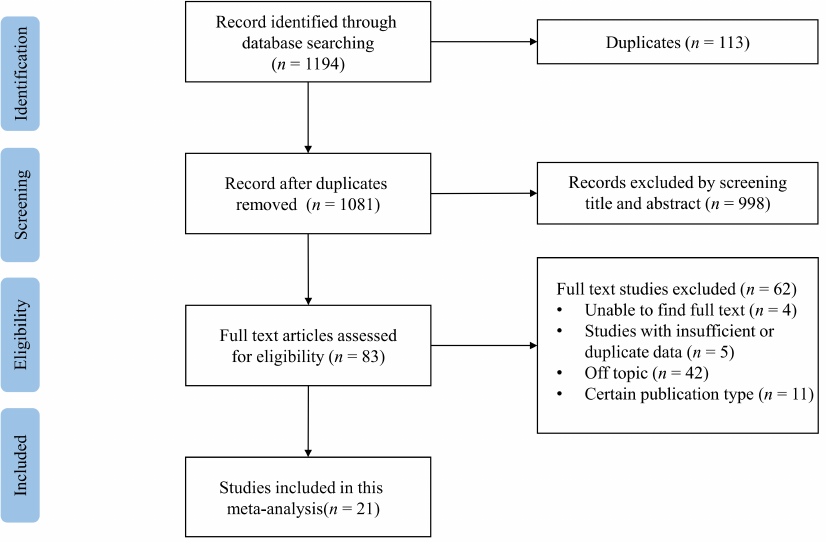
Figure 1. Flowchart of study selection.